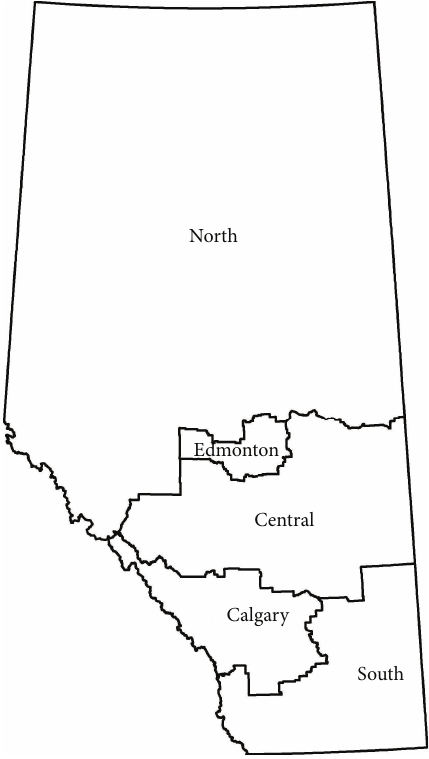
Figure 1: Map of Alberta depicting administrative health